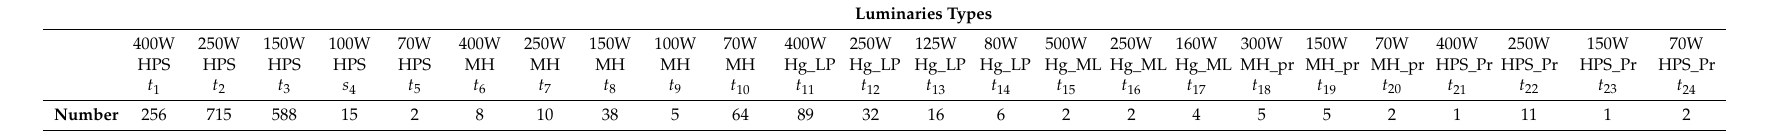
Table 1. Number of luminaries, for each type, installed in the case study street lighting system.